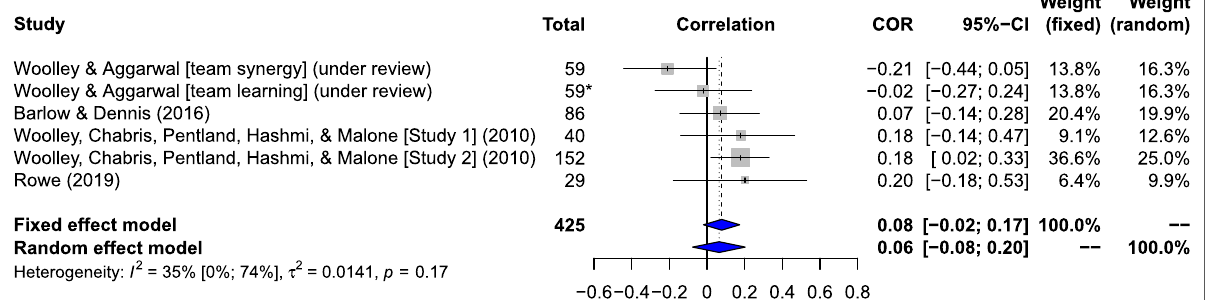
Fig. 5 Forest plot: Average IQ and Criterion Task Performance. Note. Results are displayed for a meta-analysis using a random effects model for correlations between average IQ scores and group performance on criterion tasks. The average IQ is operationalized using the total IQ scores of each individual member divided by the number of members ( ∑ IQ / n). The study by Barlow and Dennis (2016) did not apply the c-factor to the = criterion task (the profit maximization task) because the authors found it was not valid. Studies behind the other (five) correlations, however, did apply both the c-factor and Av.IQ to the same criterion task—allowing for relative comparison. The Wonderlic Personnel Test (WPT) was used for all except Woolley et al. (2010) Study 1 where 18 odd items of 36-item Raven’s Advanced Progressive Matrices were used and in Rowe (2019) where the ICAR-16 was used. Box sizes are relative to sample size weights. *Two effects (team learning and team synergy) by Woolley and Aggarwal (under review) from one unique sample (n 59) were included in this meta-analysis, leading to a total N 425 when the sample was added on the basis of = = each unique effect or a total N 366 when the sample was added on the basis of each unique =